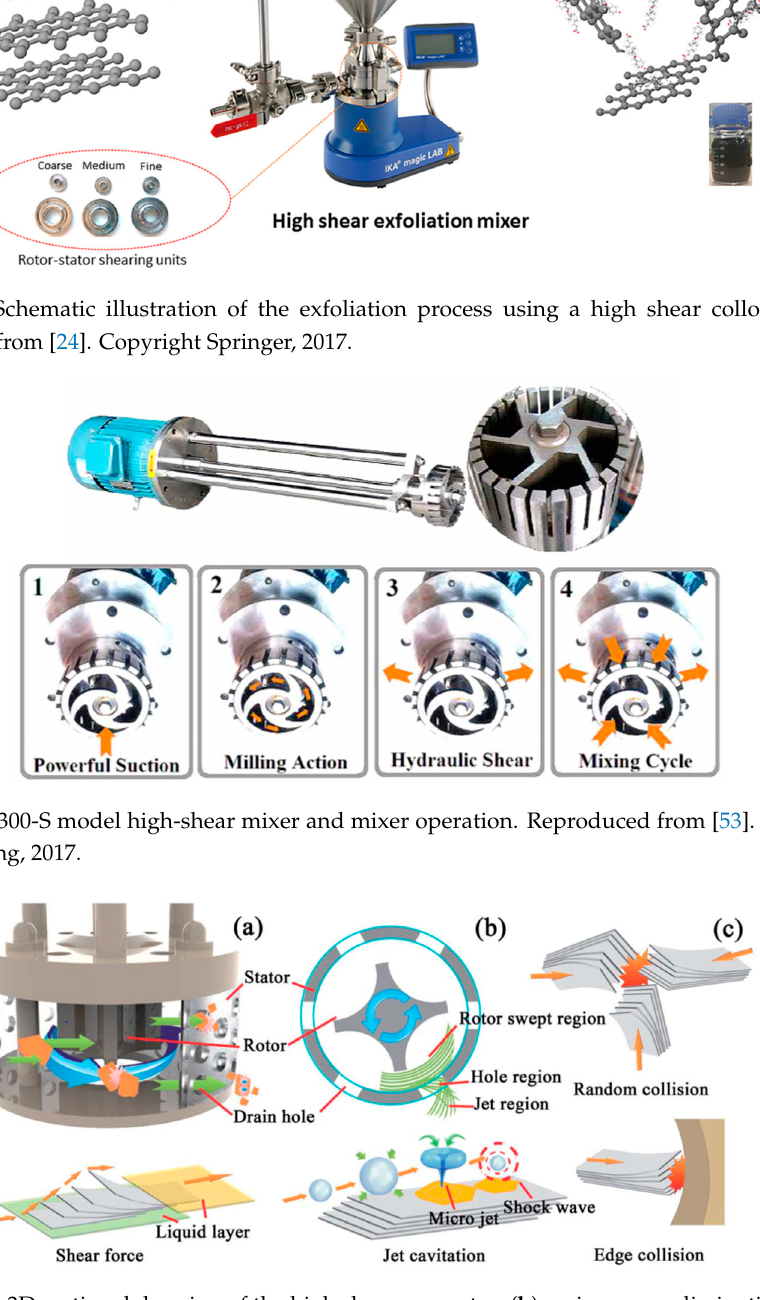
Figure 32. ( a ) 3D sectional drawing of the high shear generator; ( b ) main energy dissipation regions